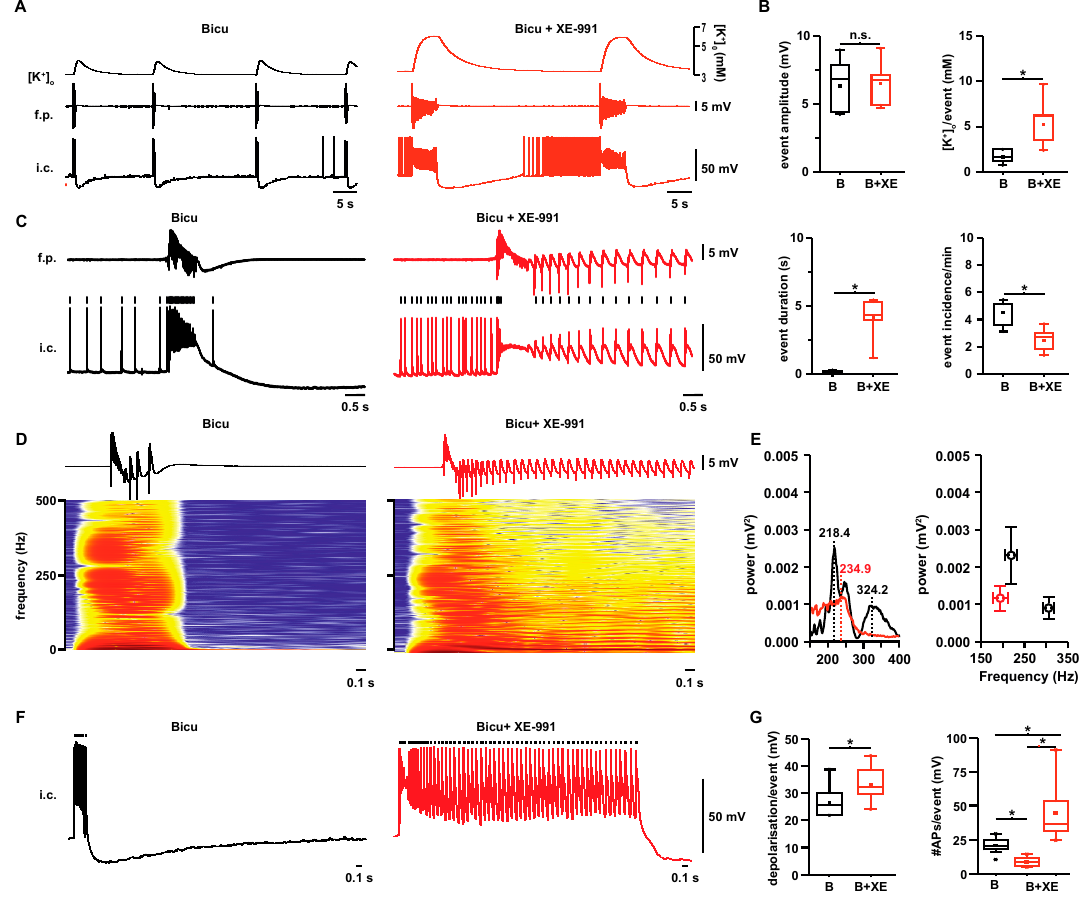
Figure 1. Properties of ILEs and SLEs: ( A ) Simultaneous recording of field potential (f.p.), extracellular potassium concentration ([K + ] o ) and intracellular recording from CA3 pyramids (i.c., bottom traces) during interictal-like events (ILEs) induced by bicuculline (black) and seizure-like events (SLEs) induced by the co-application of bicuculline and XE-991 (red); ( B ) ILEs and SLEs differed significantly in event-associated [K + ] o -rises, event duration and incidence, while event amplitudes remained unaltered (* p < 0.05, n = 6, paired t -test); ( C ) Detail of typical f.p. recording and i.c. correlate during ILEs and SLEs. Bicuculline-induced ILEs are short paroxysmal discharges characterized by a slow wave with superimposed high-frequency oscillations (HFOs). The simultaneous i.c., recording shows a typical depolarization with cell firing. SLEs are characterized by an initial ILE followed by repetitive brief bursts. Compared with ILEs, cell firing is reduced during the first component (slow wave) of the discharge with concomitantly increased cell firing during the after discharges; ( D ) and ( E ) Fast Fourier transform (FFT)-based frequency sonograms of exemplary ILE and SLE. During bicuculline-induced ILE, HFOs typically displayed two main peaks (see corresponding power spectrum in E , black line). During SLEs, the faster oscillatory peak was abolished (red line). Right: Averaged main frequency and power of HFOs during ILEs (black) and SLEs (red) ( n = 6); ( F ) I.c. recording during ILEs (black trace) and SLEs (red trace): bicuculline bursts are marked membrane depolarizations with high frequency action potential (AP)-firing (small black line on top). SLEs also begin with a pronounced membrane depolarization, however, with less firing, followed by repeated cell bursting; and ( G ) Compared with ILEs (black), SLEs (red) were associated with increased membrane depolarization amplitudes (left). The number of APs decreased significantly during the initial burst under SLEs (red box, middle) compared with ILEs. When the total number of APs during the whole discharge was measured (red box on the right), SLEs were associated with a marked increase in neuronal firing compared with ILEs. (* p < 0.05, n = 11 cells from six slices, paired t -test).